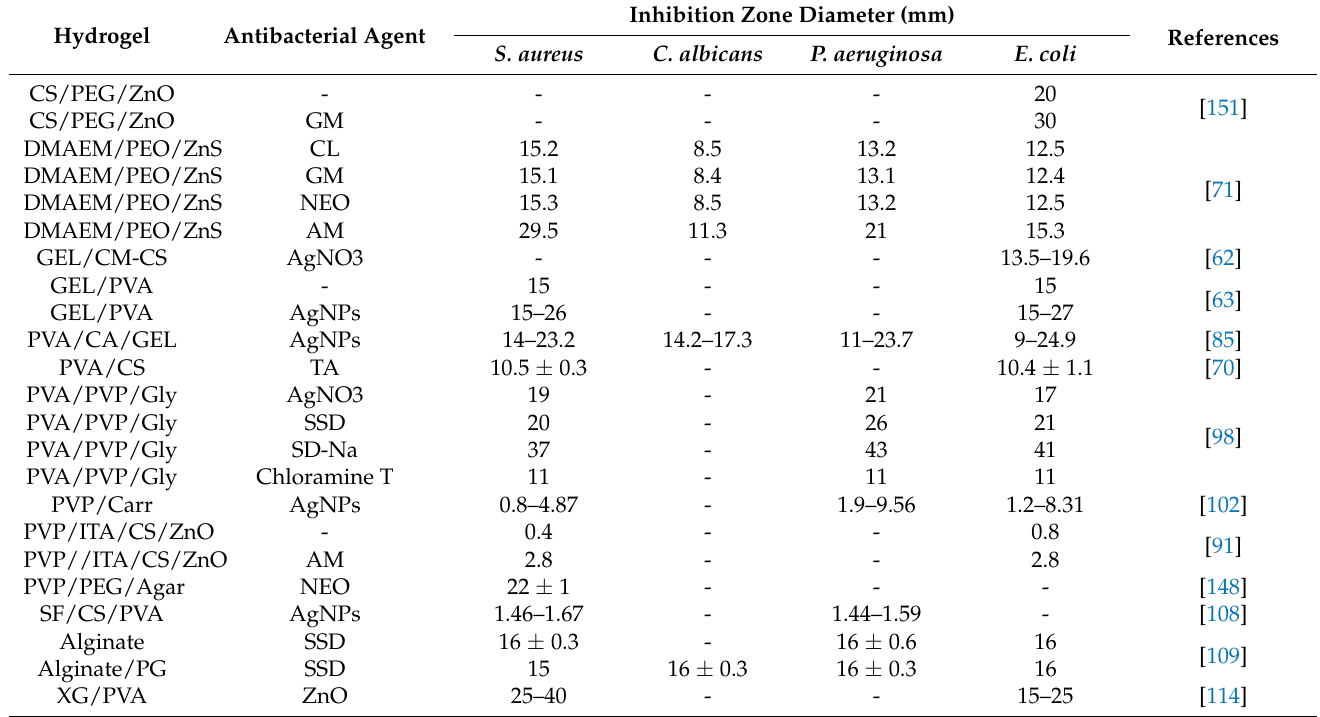
Table 4. The in vitro antimicrobial tests of hydrogels were explored using microorganisms on Gram-positive bacteria ( S. aureus , C. albicans ) and Gram-negative bacteria ( P. aeruginosa , E. coli ). Table 4. Antibacterial activity data of the hydrogel wound